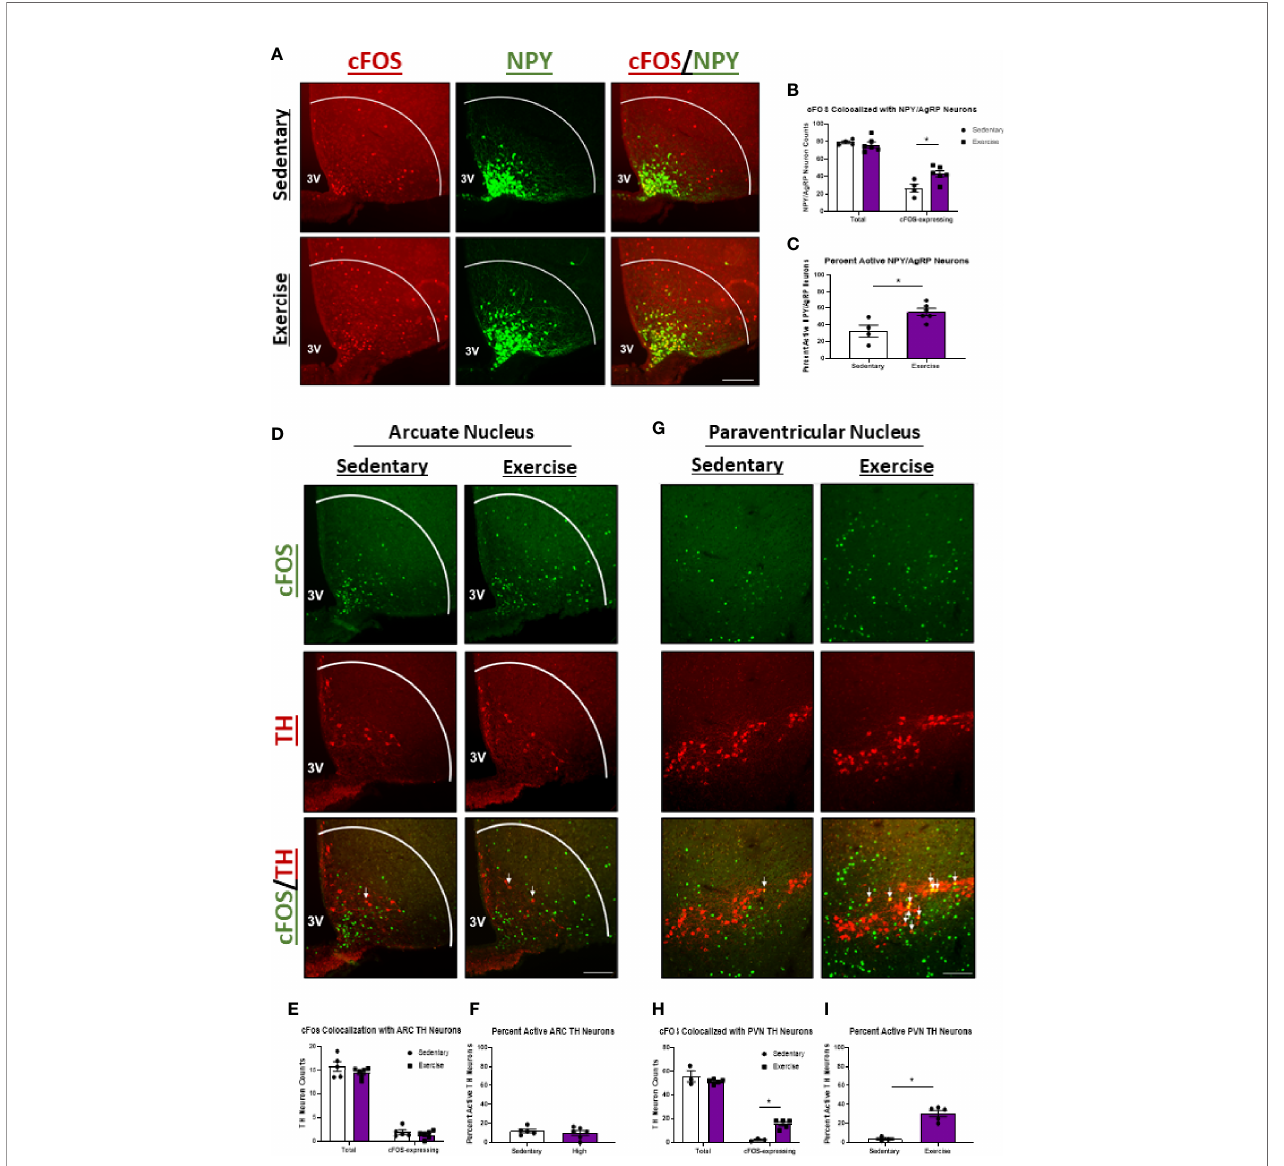
FIGURE 3 | NPY/AgRP ARC and TH PVN neuron activity is elevated 1 hour after acute high intensity treadmill exercise in fasted male mice. (A) Representative images of cFOS (red) colocalized with NPY/AgRP ARC neurons (green) in fasted male mice 1 hour after sedentary trials or high intensity treadmill exercise. (B) Total and cFOS-expressing NPY/AgRP ARC neurons and (C) Percent active NPY/AgRP ARC neurons (n = 4-6/group). (D) Representative images of cFOS (green) colocalized with TH ARC neurons (red) in fasted male mice 1 hour after sedentary trials or high intensity treadmill exercise. (E) Total and cFOS-expressing TH ARC neurons and (F) Percent active TH ARC neurons (n = 5-6/group). (G) Representative images of cFOS (green) colocalized with TH PVN neurons (red) in fasted male mice 1 hour after sedentary trials or high intensity treadmill exercise. (H) Total and cFOS-expressing TH PVN neurons and (I) Percent active TH PVN neurons (n = 3-5/group). 3V = Third ventricle; Scale bar = 50um. Data represented as mean ± SEM. *indicates p < 0.05 vs. sedentary